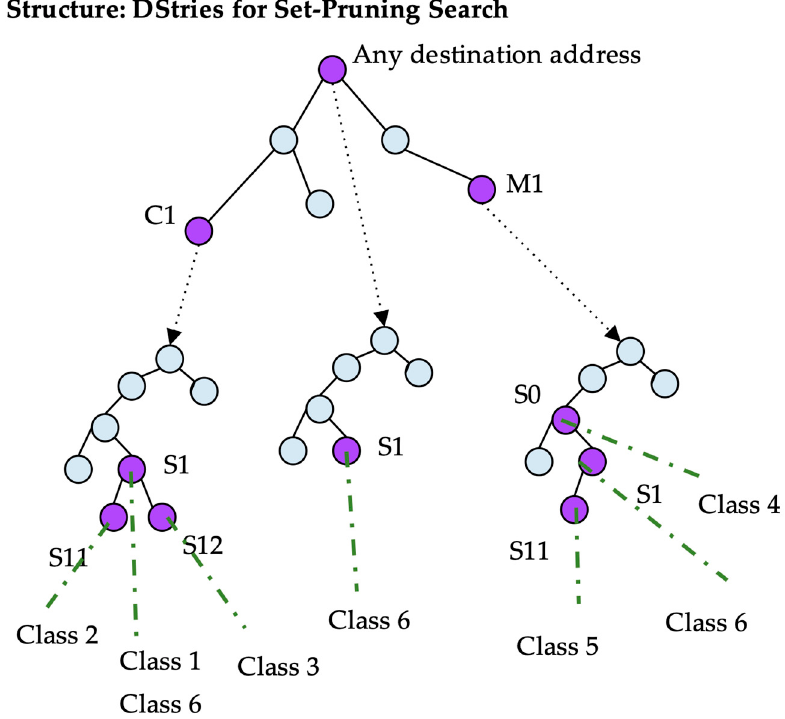
Figure 7. Set-pruning DStries example.